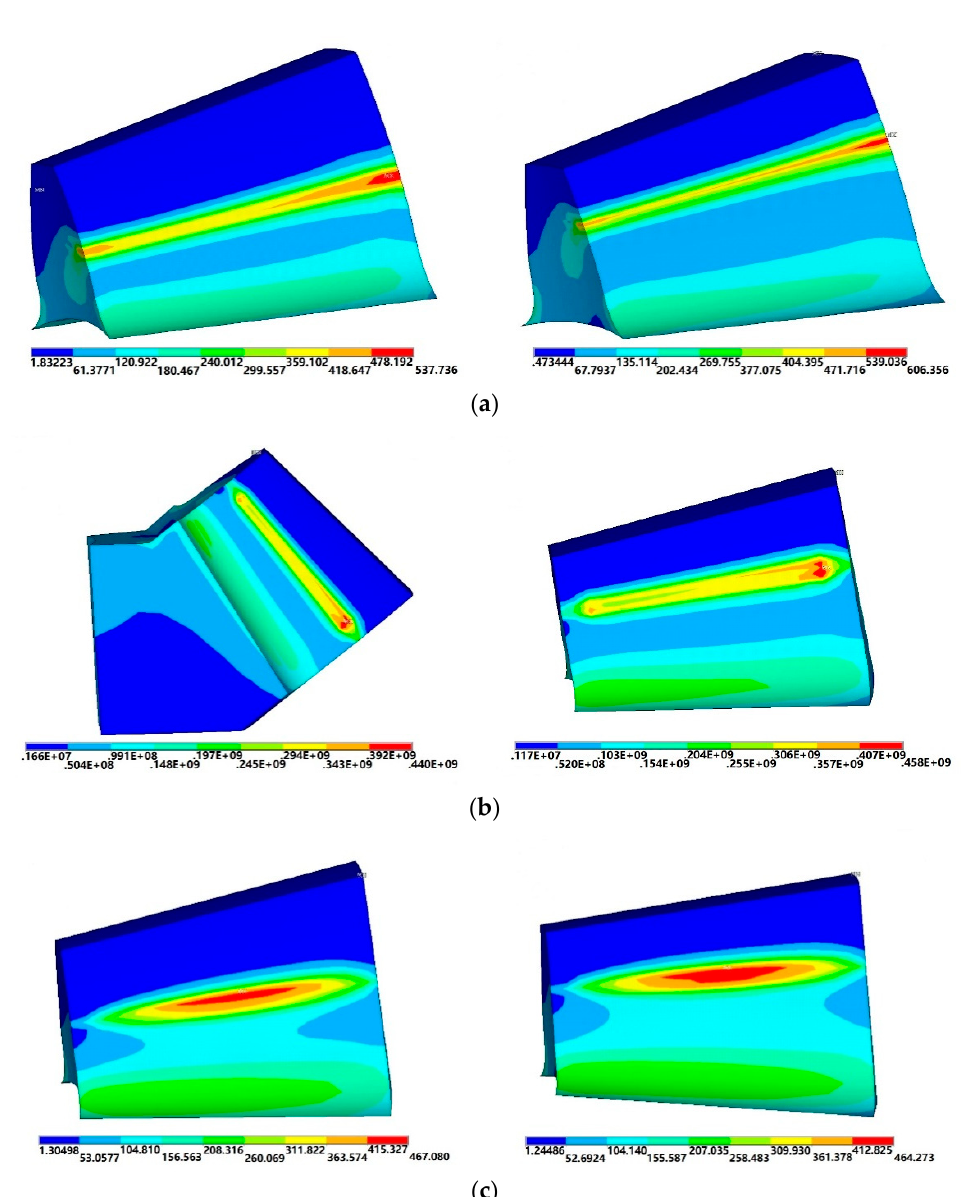
Figure 15. Distribution of contact stress on the tooth surface for pinion (left) and the gear (right) when ∆ γ = 1. ( a ) No modification, ( b ) Case4 and ( c ) Case1.